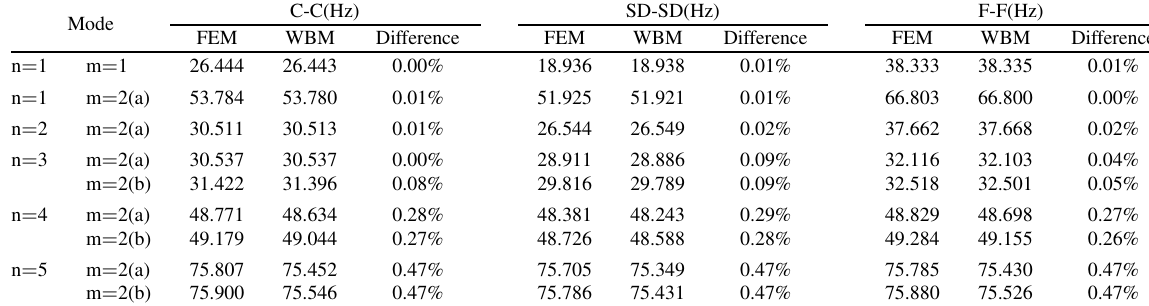
Table 5 Comparison of natural frequencies of model M2 calculated by FEM and